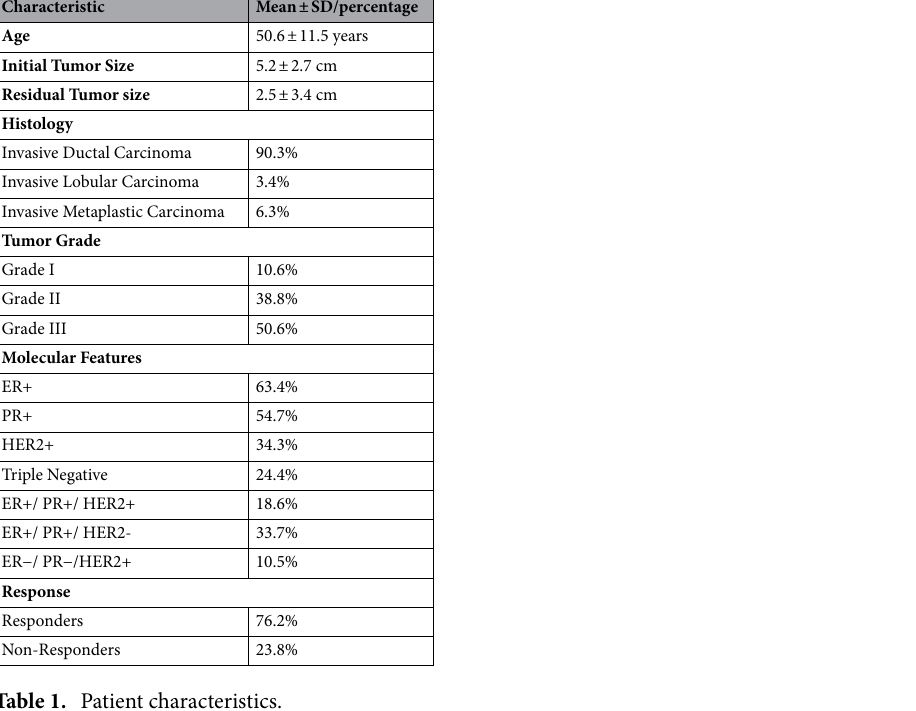
Table 1. Patient